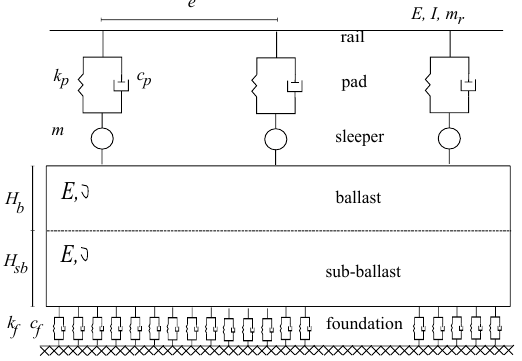
Figure 1. Track model with continuous modeling of the granular